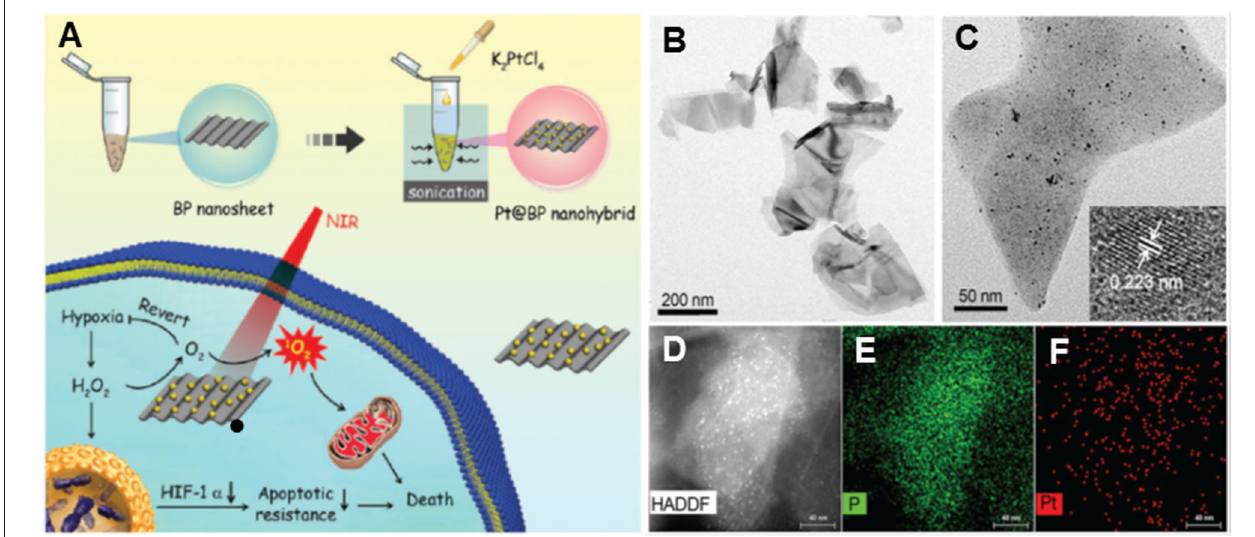
FIGURE 3 | (A) Illustration of synthesis and antitumor process of Pt/BP nanocomposites as well as their characterization: (B) TEM image of BP NSs and (C) Pt/BP nanocomposites (inset shows the high-resolution TEM image of a Pt NP), (D) high-angle annular dark-field scanning TEM (HAADF-STEM) image of Pt/BP, elemental maps of (E) P, and (F) Pt. Adapted with permission from Ouyang et al. (2018). Copyright 2018 Royal Society of